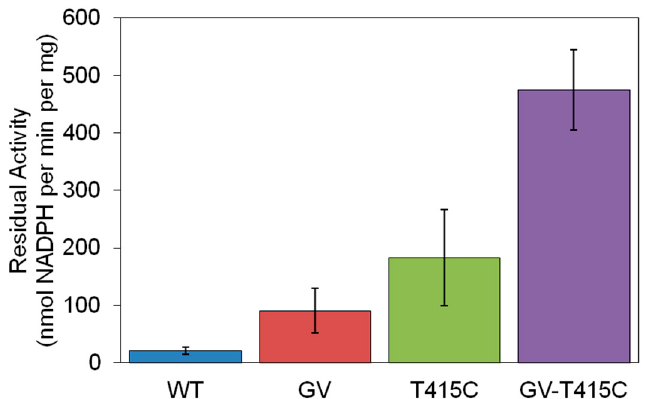
Figure 4. Residual specific activity of CHMO variants after ten-minute incubation at 45 °C. Variants GV and T415C displayed 4.4 and 8.8-fold improved residual activity over WT. Variant combining the stabilizing mutations GV and T415C dramatically increased residual activity 23-fold suggesting a synergistic effect on protein